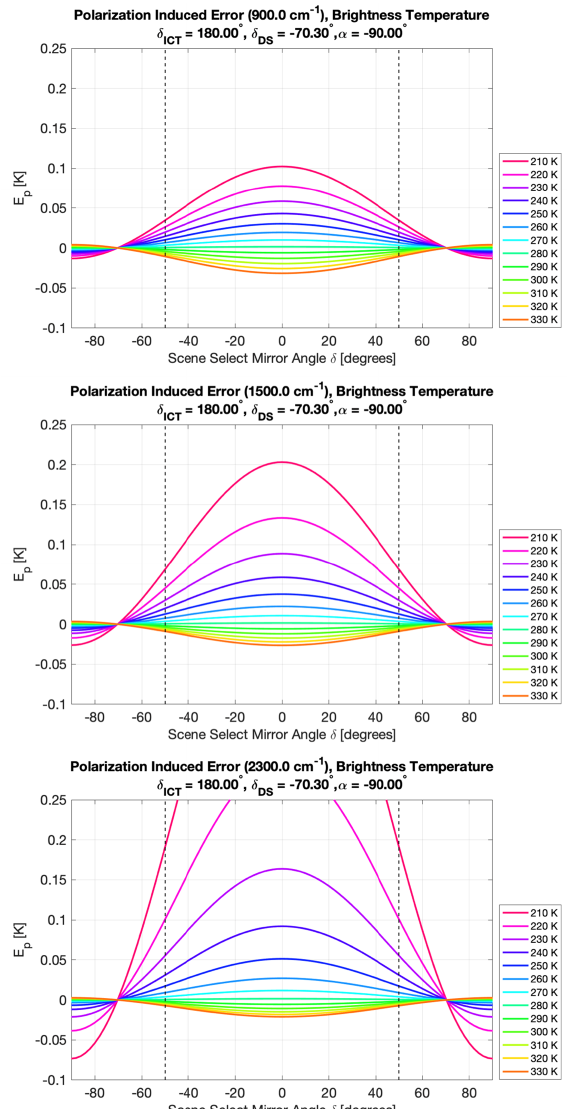
Figure 6. Modeled polarization-induced calibration error at 900 cm − 1 ( top panel ), 1500 cm − 1 ( middle panel ), and 2300 cm − 1 ( bottom panel ) as a function of scene brightness temperature and scene select mirror angle. Constant values were used for the scene select mirror and instrument polarization ( p r = 0.0055, p t = 0.08) and a sensor polarization angle of 0° was used for the preliminary model. The vertical dashed lines indicate the angular extent of the CrIS cross-track scan of the Earth.